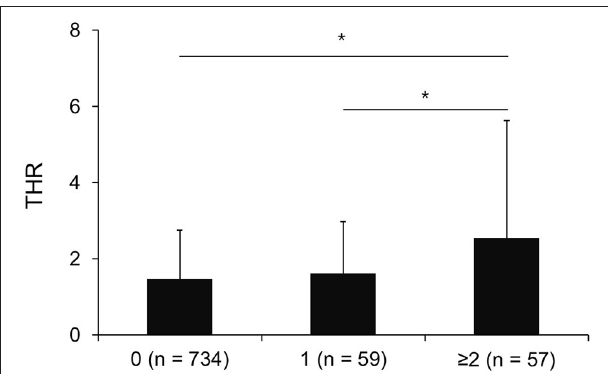
FIGURE 1 | Mean THR among patients without ICAS lesion ( n = 734), patients with single ICAS lesion ( n = 59), and patients with multiple ICAS lesions ( n = 57). The X axis represents the number of ICAS lesions. * < 0.05 based on Tukey b test. The error bar represents the standard